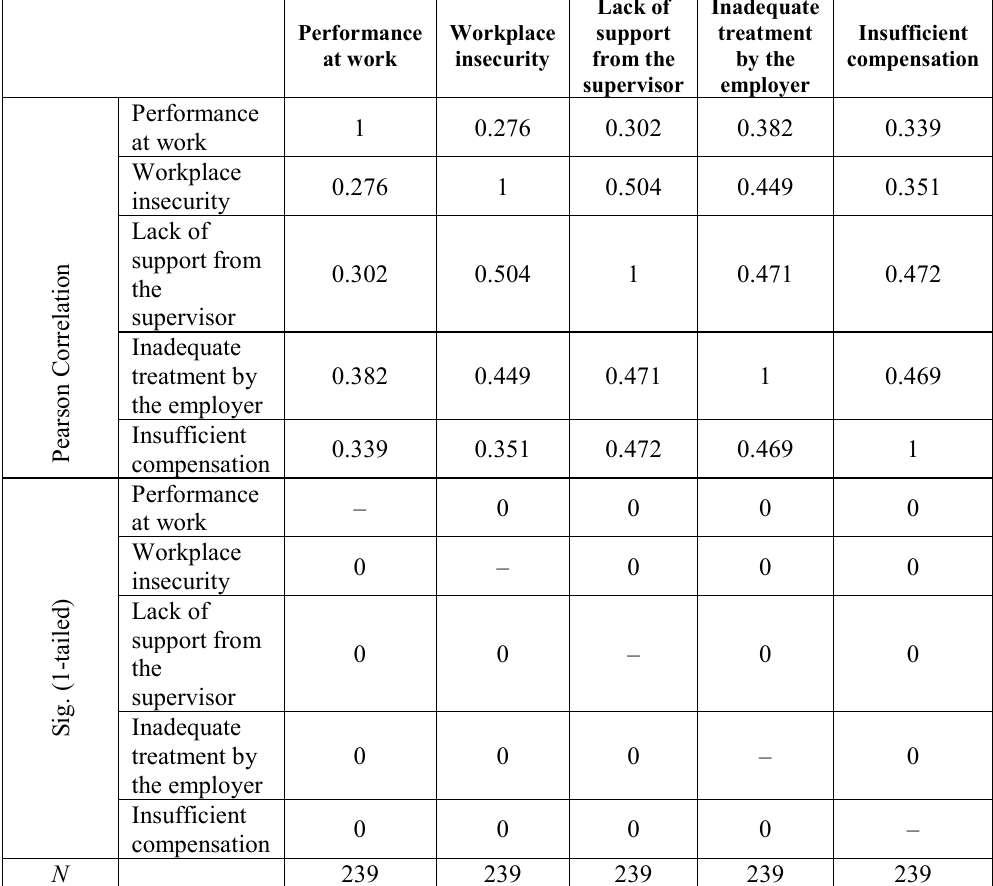
Table 6. Pearson Correlation – Performance at